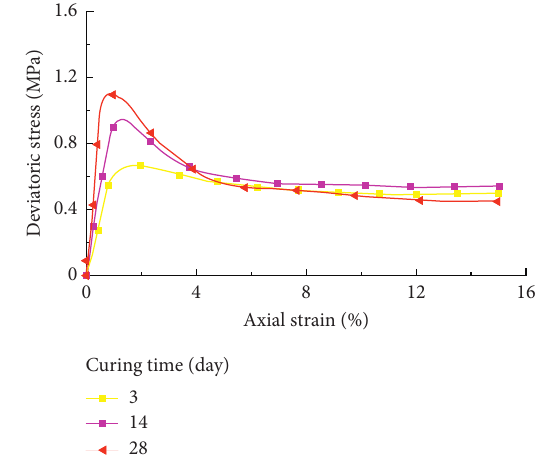
Figure 16: Deviatoric stress-axial strain relationship for stabilized soils with different curing times (confining pressure � 0.1MPa; stabilizer content � 5%).